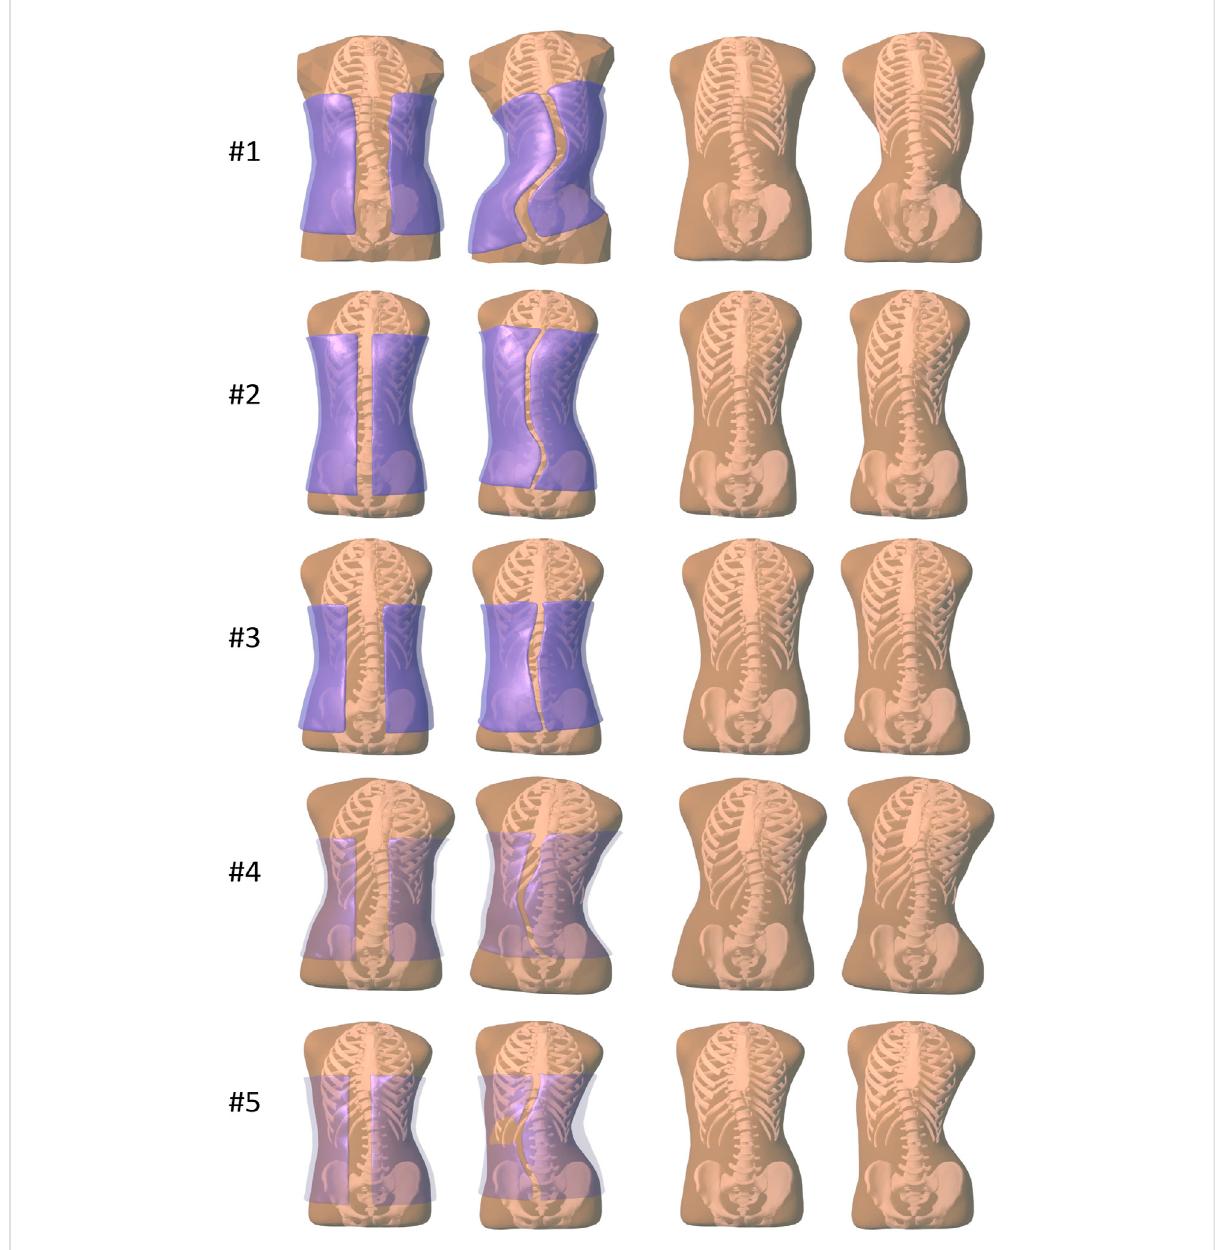
FIGURE 2 Images of all the subjects evaluated in our study. From left to right, (i) before brace optimization, with the initial brace geometry shown semi- transparentpurple, (ii) afterbrace optimization,with the fi nalbrace geometryshown semi-transparentpurple,(iii)beforebraceoptimization, justthe initial trunk geometry, (iv) after brace optimization, showing the deformed trunk